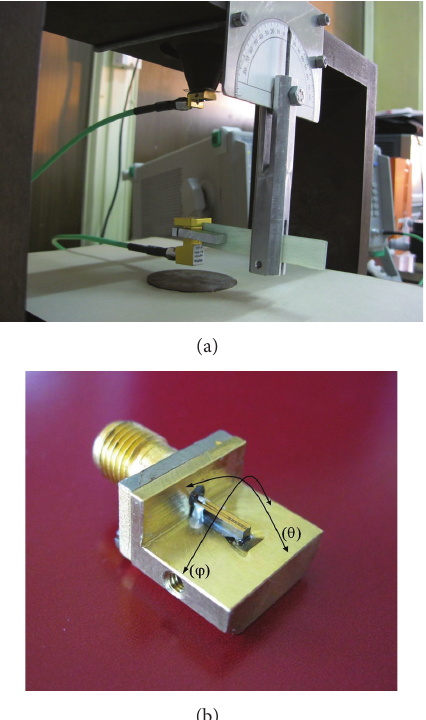
Figure 7: Experimental setup dedicated to CRLH antenna radiation characteristic in transversal plane (a) and definition of the measure- ment planes (b).